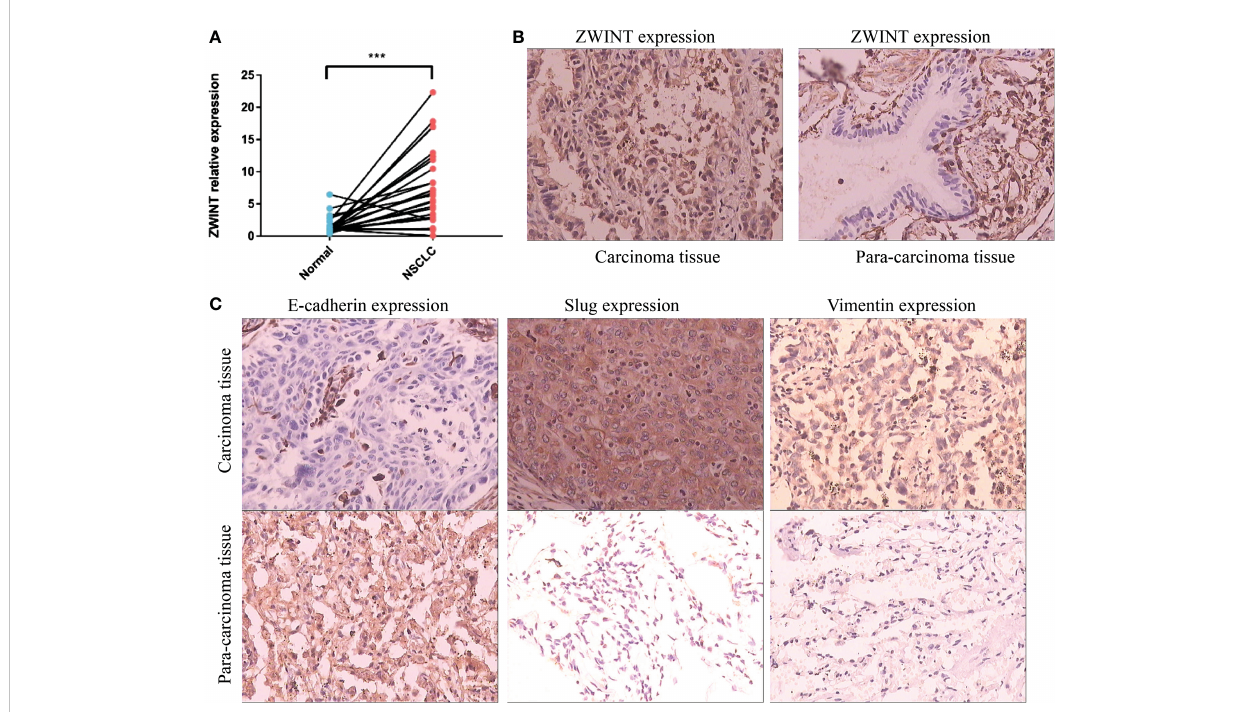
FIGURE 10 Expression validation of the ZWINT gene in NSCLC. (A) RT-qPCR analysis of 30 paired frozen cancerous and paracancerous tissues. (B) IHC experiments veri fi ed the expression levels of the ZWINT gene in cancerous and paracancerous tissues. (C) IHC experiments veri fi ed the expression levels of EMT pathway-associated markers in cancerous and paracancerous tissues. *** indicates p < 0.001.